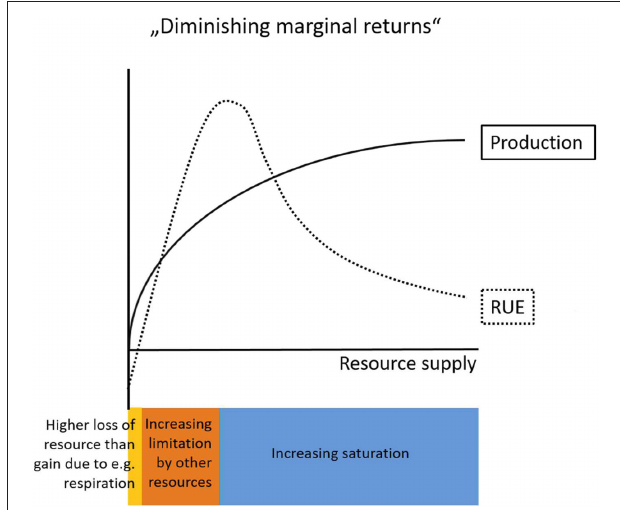
FIGURE 1 | Conceptual graph describing the relationship of resource use efficiency (RUE) and production with increasing levels of resource supply. The law of “Diminishing marginal returns” predicts decelerating rates of production with increasing resource supply. RUE on the other hand is usually negative at very low resource supply rates (yellow) due to resource losses as a consequence of general maintenance mechanisms (e.g., respiration). With increasing resource supply RUE increases until limitation by other resources constrains resource needs (orange). Finally, at very high resource supply levels saturation sets in (blue) which gradually decreases the amount of a particular resource that can be incorporated into new